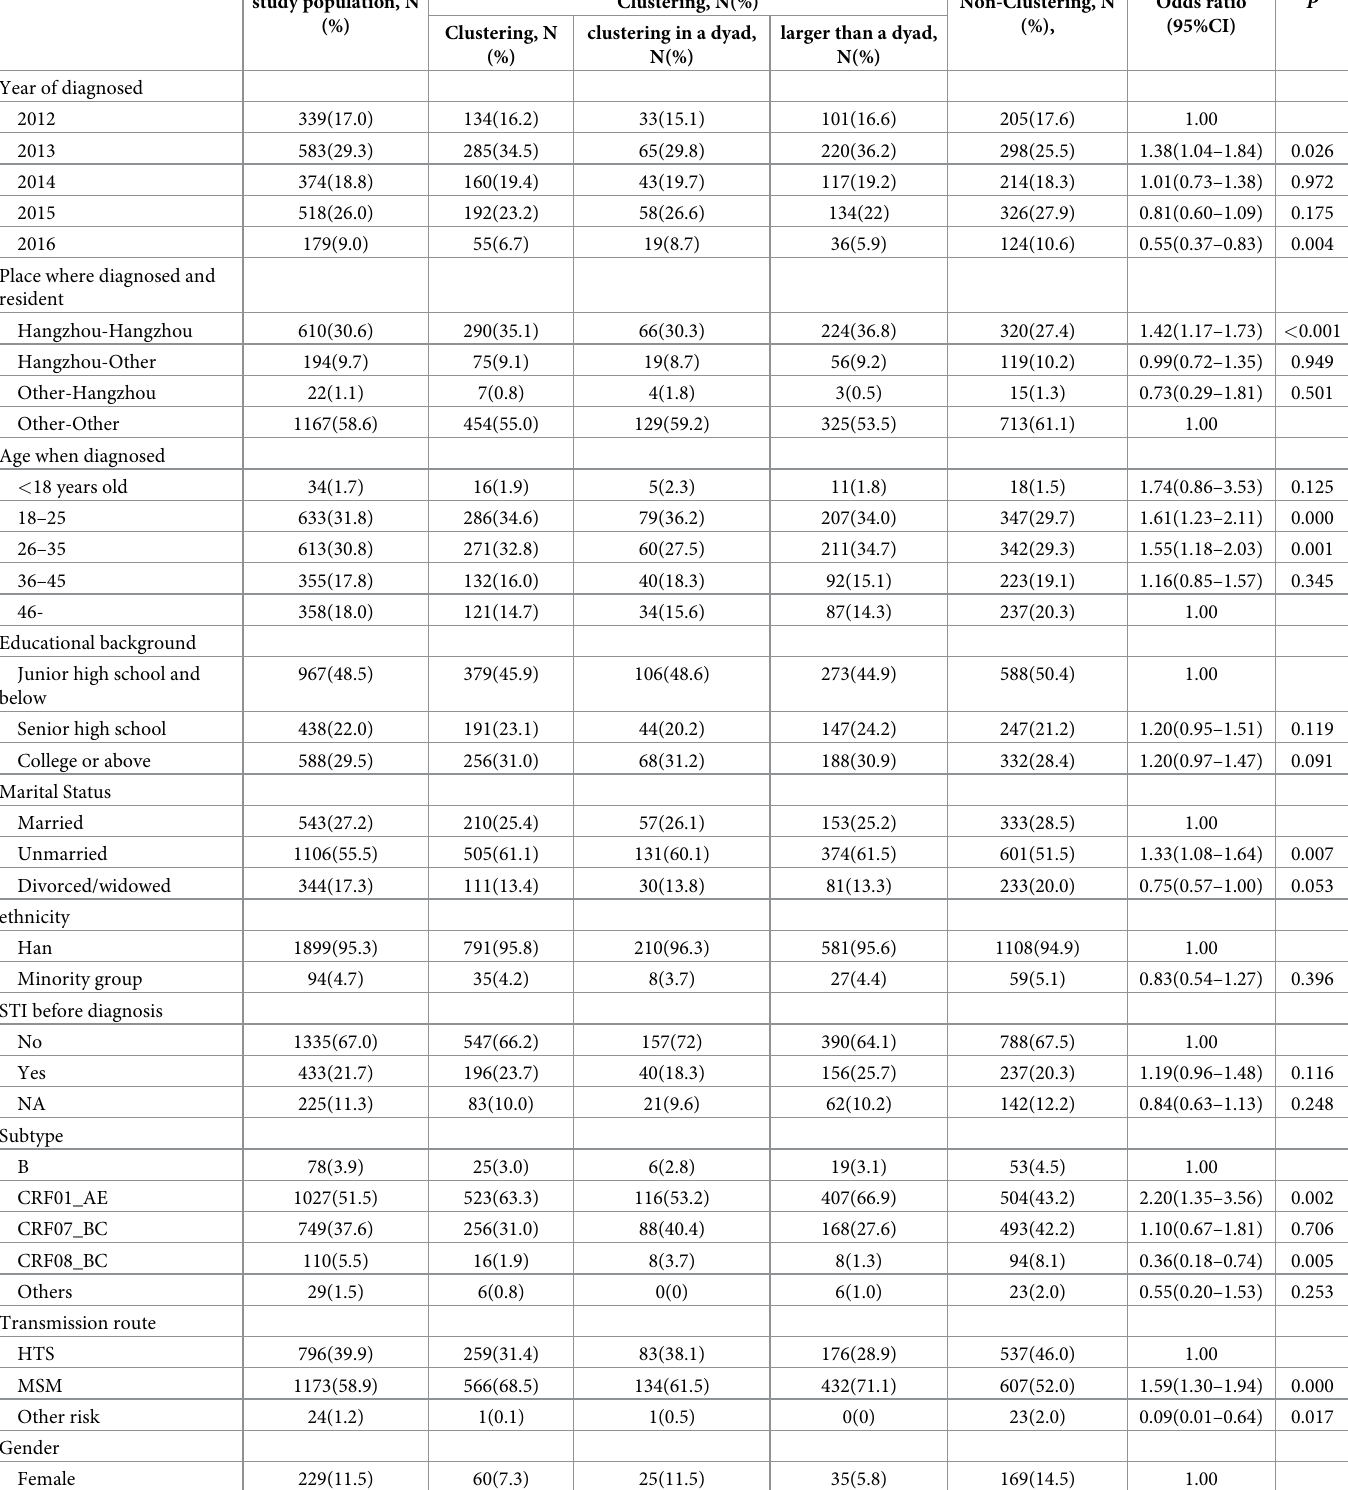
Table 1. Population characteristics between clustering and non-clustering